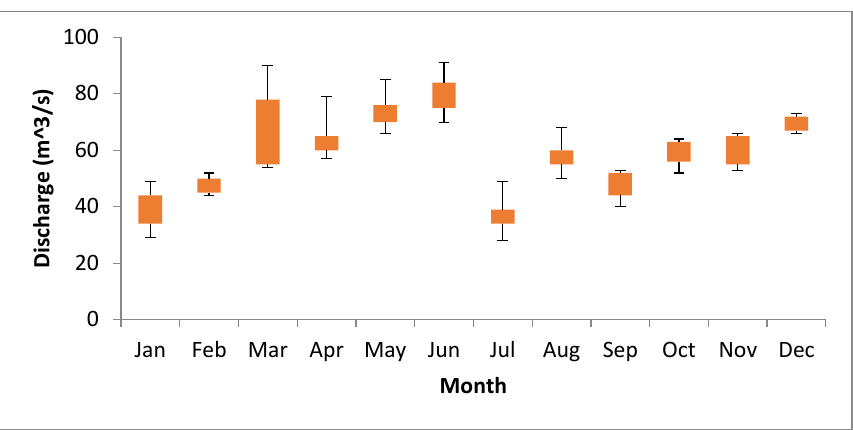
Figure 4. Monthly discharge for the basin.